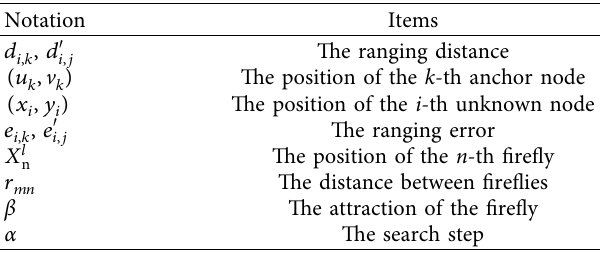
Table 1: Notation of